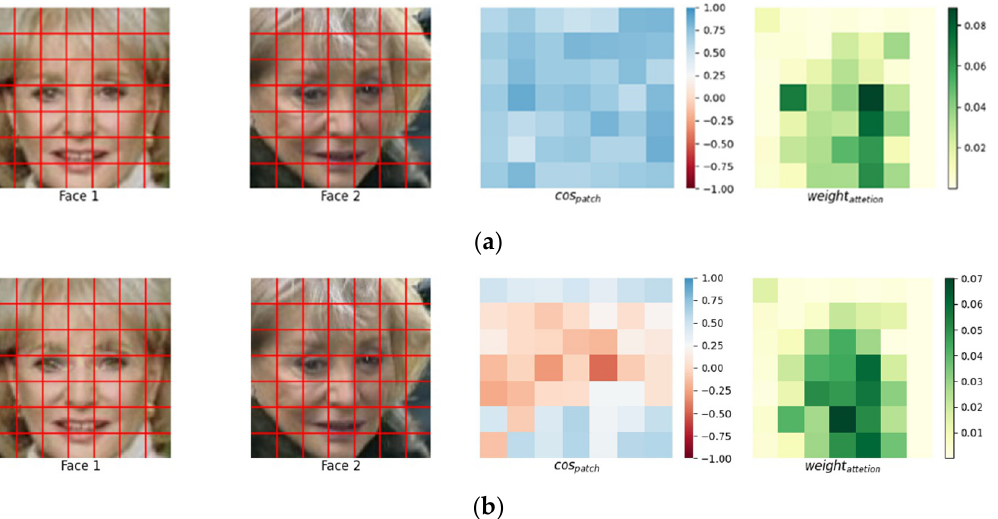
Figure 10. Before and after eye-based non-targeted attack. ( a ) Visualization of facial features of the same person from different angles. ( b ) Visualization of face features after being attacked.